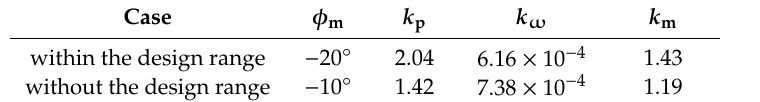
Table 3. Different sets of parameters. Table 3. Di ff erent sets of parameters.